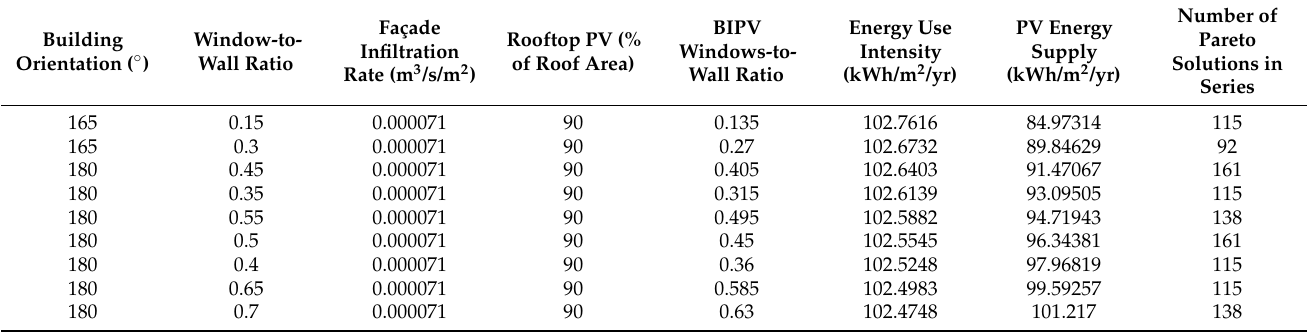
Table 4. Configuration of Pareto optimal solutions of stage